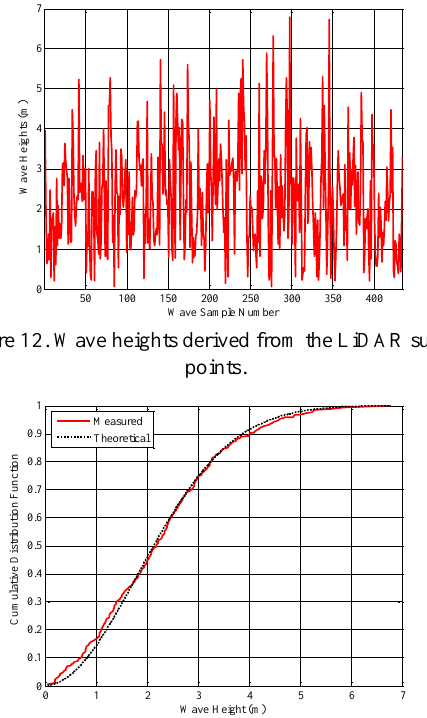
Figure 13. Cumulative distribution functions of the measured wave heights and the Rayleigh variable.